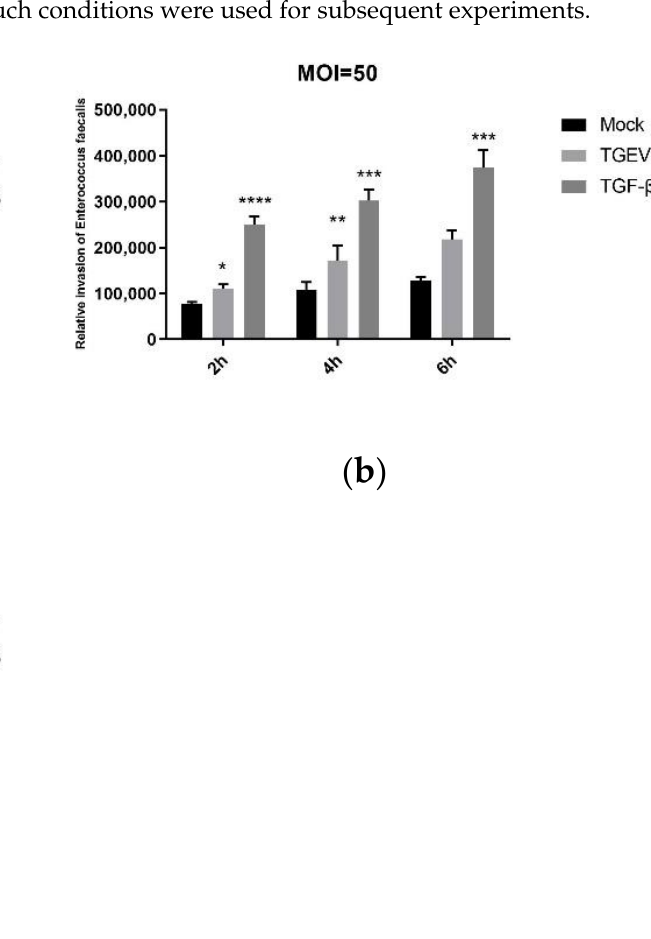
Figure 8. Adhesion of E. faecalis to IPEC-J2 cells at different infection rates and time points. ( a ) MOI = 10; ( b ) MOI = 50; ( c ) MOI = 100. * p < 0.05, ** p < 0.01, *** p < 0.001, **** p < 0.0001